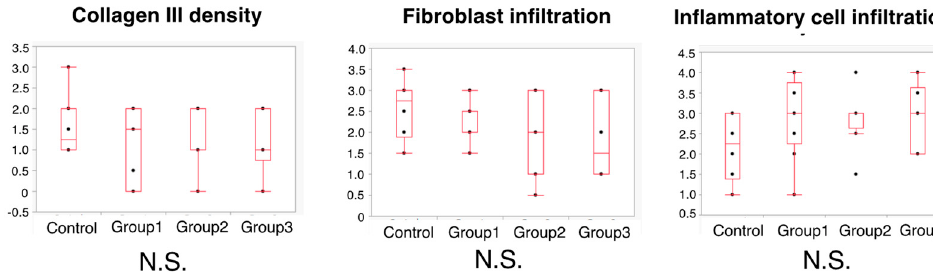
Figure 10. Histopathological assessment on POD 5 using Ehrlich and Hunt numerical scale. N.S.— not significant.